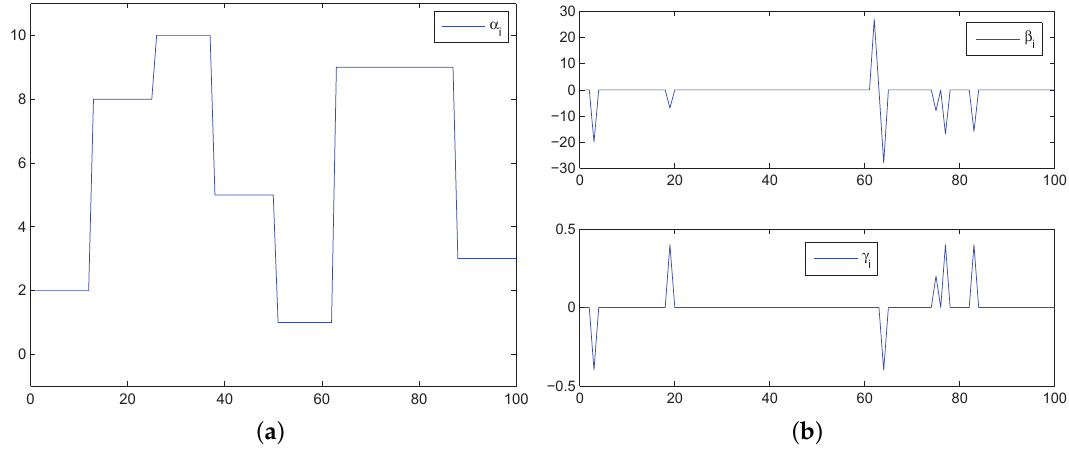
Figure 1. The time varying parameters. ( a ) α i ; ( b ) β i and γ i .